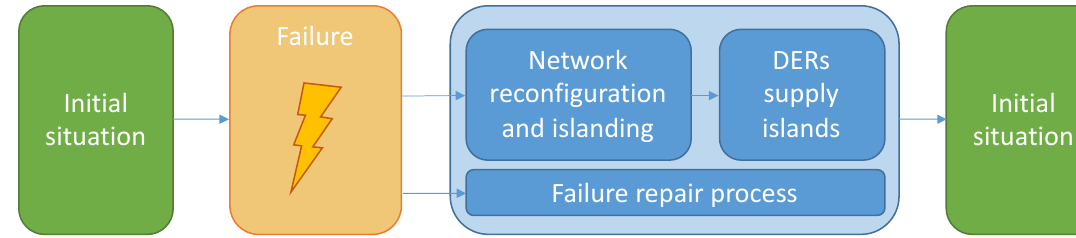
Figure 1. Action plan when a contingency occurs.